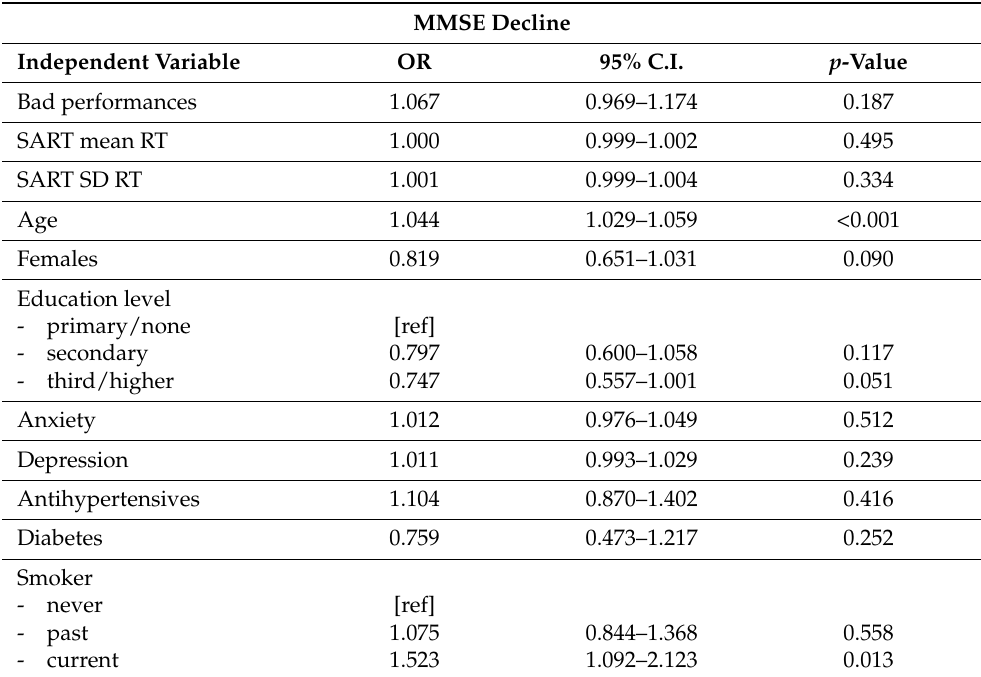
Table A7. Results for the fully adjusted per covariates binary logistic regression model 4 considering bad performances as potential predictor and having MMSE decline as